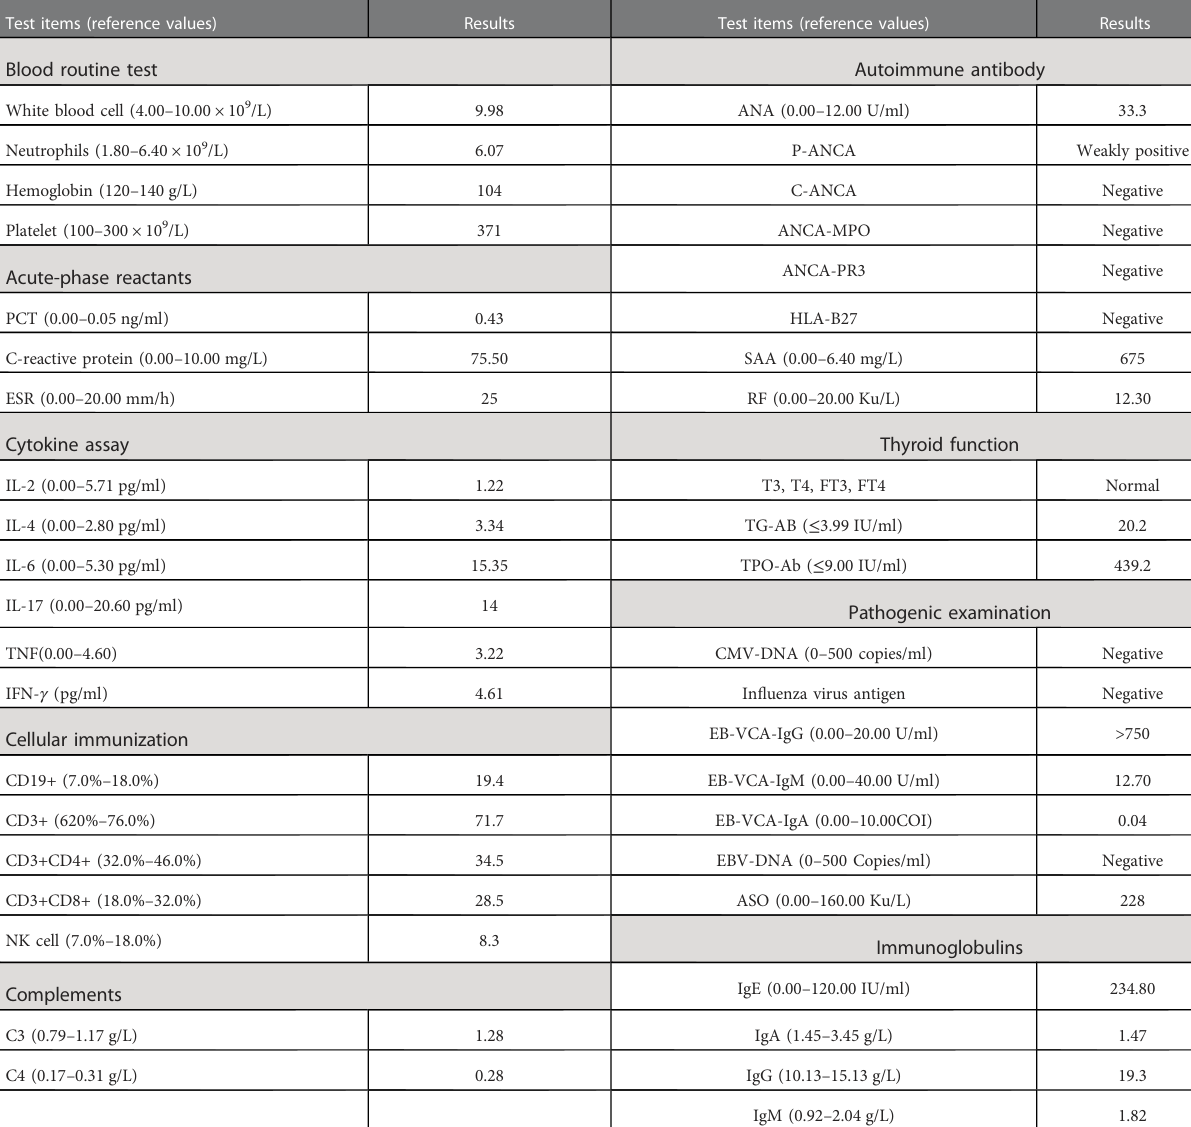
TABLE 1 Laboratory examination results at